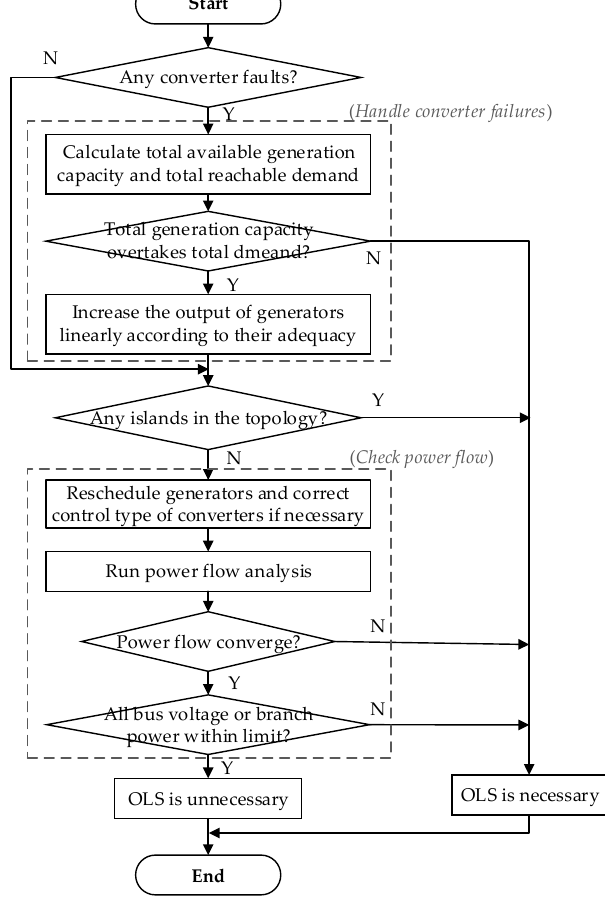
Figure 6. Flowchart of the preliminary analysis.